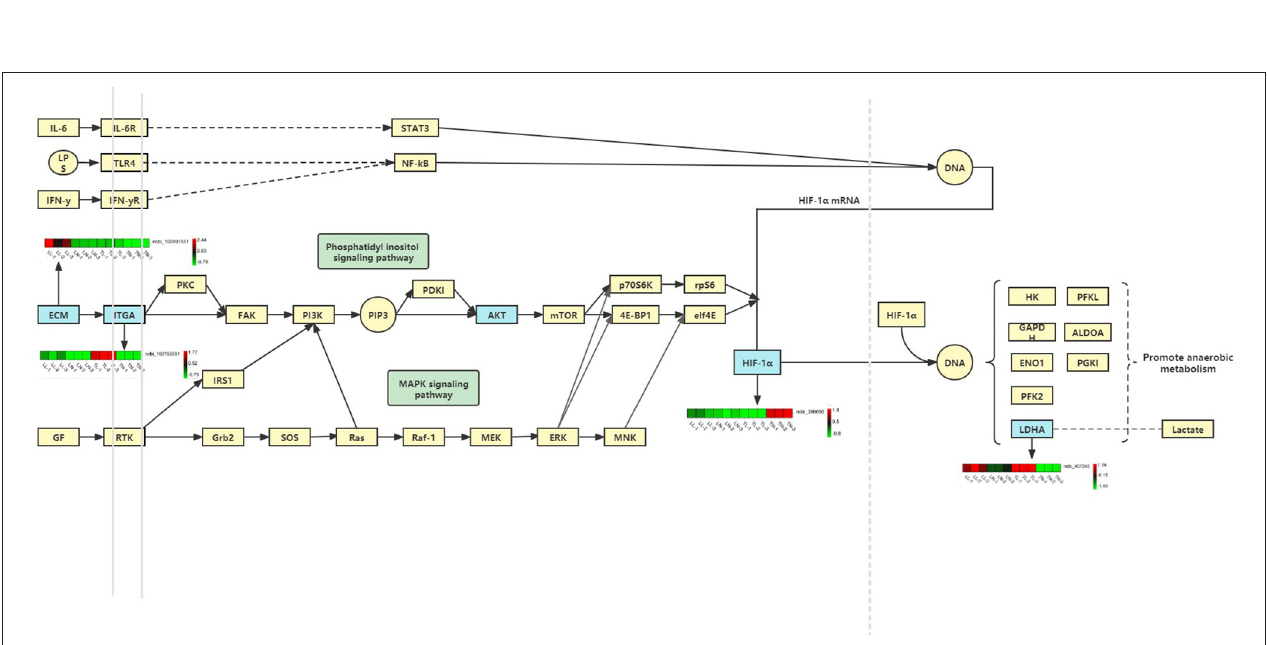
FIGURE 7 | Hypoxia induction may promote apoptosis by activating of the focal adhesion/PI3K-Akt/glycolysis pathway.